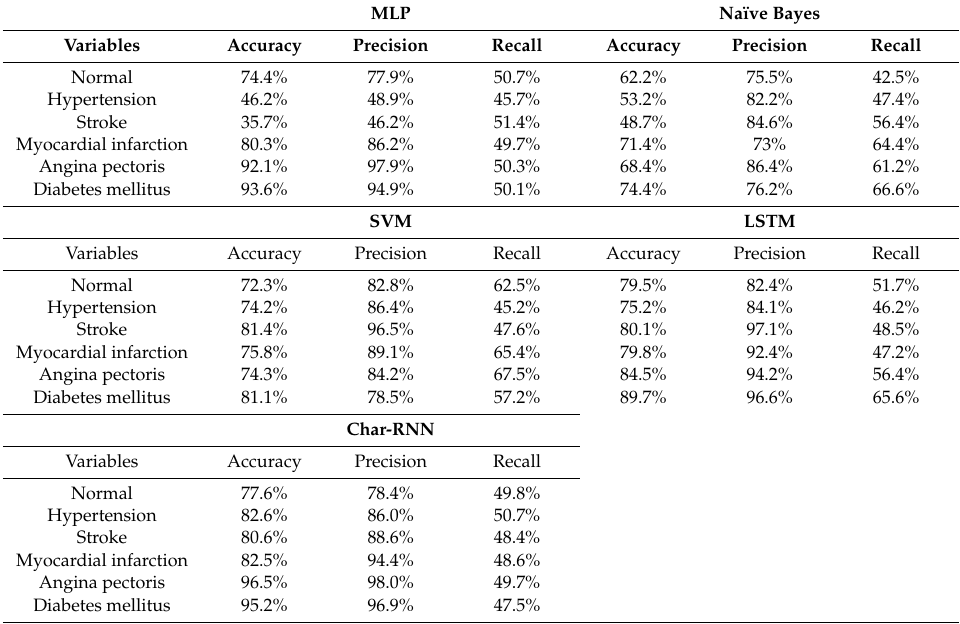
Table 4. Comparison of results of Char-RNN and other